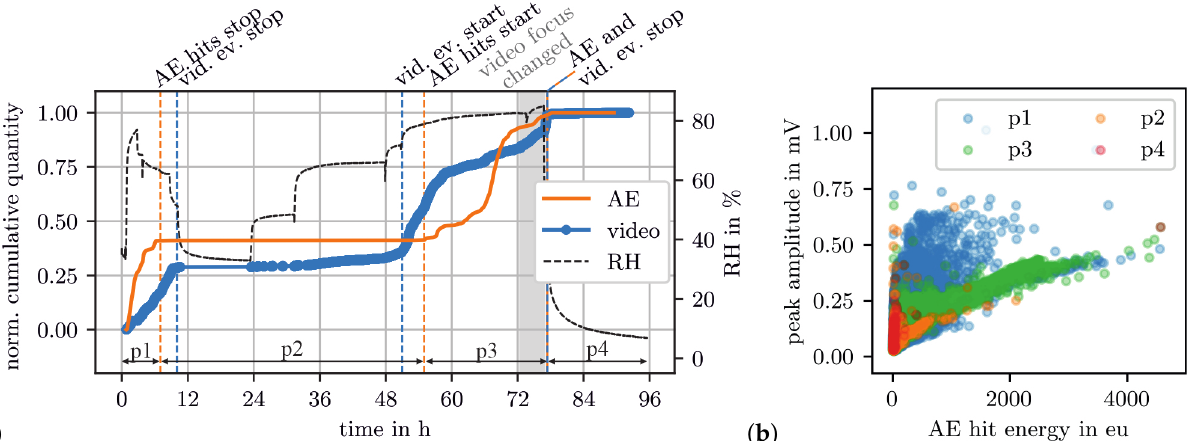
Figure 8. Results of the atmospheric corrosion experiment. ( a ) Measured relative humidity (RH) and calculated normalized cumulative AE hit energy and normalized cumulative video event count. The vertical dashed lines represent the times when the cumulative quantities indicated the stopping and starting of corrosion activity. The gray area marks a time span in which the focus of the camera was changed. ( b ) Peak amplitude versus AE hit energy of the four phases p1–p4 of the